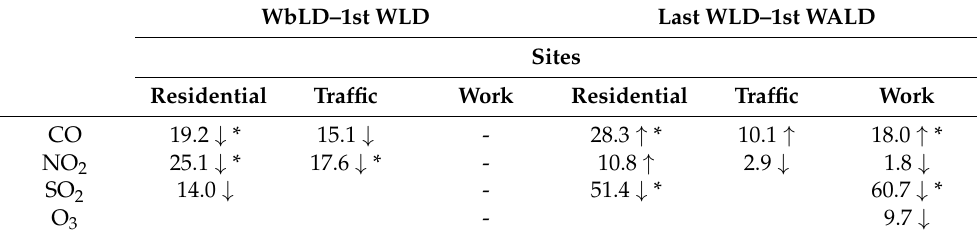
Figure 6. Concentrations of gaseous criteria air pollutants (CO, SO 2 , NO 2 , and O 3 ) in the residential, traffic, and work sites during the last week of pre-lockdown period (the week before the lockdown), the first and last week of lockdown period, and the first week after the lockdown. Table 3. Weekly comparisons of the gaseous criteria air pollutants measured at the different sites in Riyadh before and after the lockdown and relative difference between the mean values ( ↓ denotes a decrease, ↑ denotes an increase, and * denotes significant change at the 0.01 confidence level according to the t